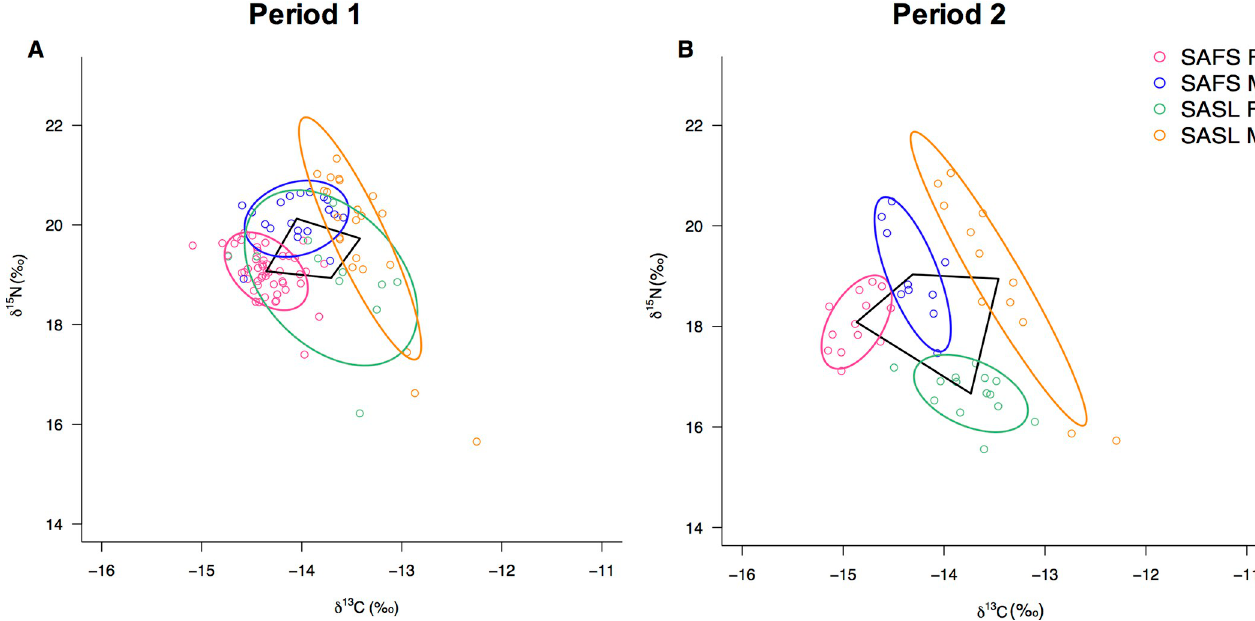
Fig 2. Standard Ellipse Area (75%) for A) Period 1 and B) Period 2. Black lines delineate community convex hull between centroids of each